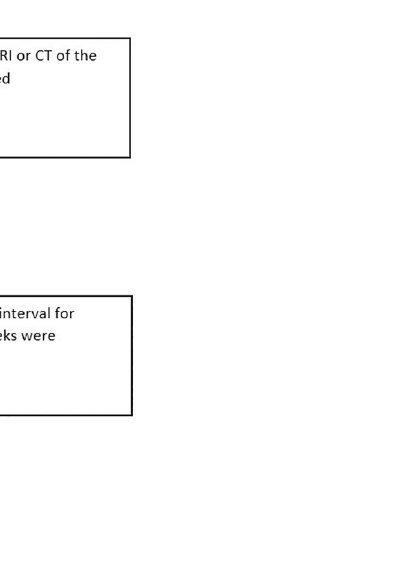
Fig 1. Schematic flow chart of the patient selection